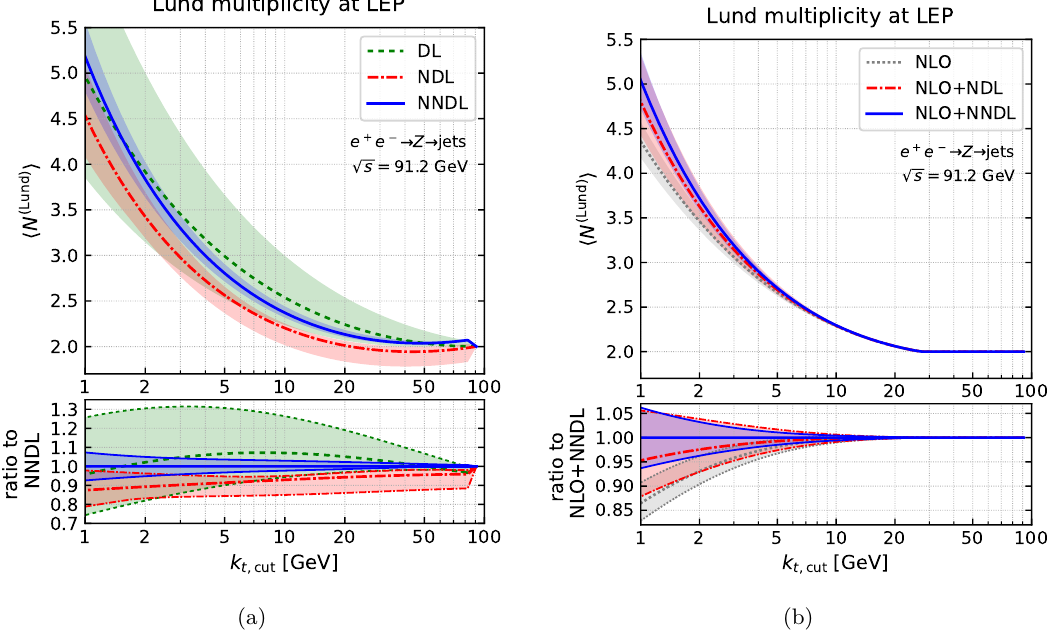
Figure 8. Left: resummed Lund multiplicity at DL (dashed, green), NDL (dash-dotted, red) and NNDL (solid, blue) as a function of k for LEP kinematics. Right: Lund multiplicity after t, cut matching with NLO. The pure NLO result is shown in dotted (grey) for reference, together with matched NLO+NDL (dash-dotted, red) and NLO+NNDL (solid, blue). The bottom panels display the ratio to the most accurate result (NNDL on the left and NLO+NNDL on the right).